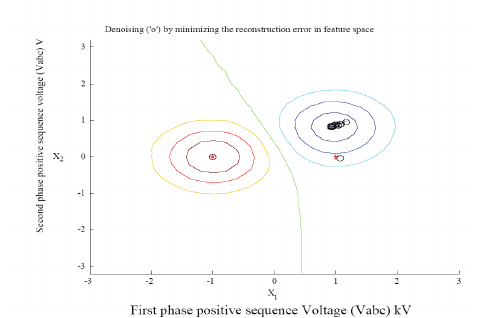
Fig. 5(e)(i). Fault location training performance of Hybrid Fig. 5(a). Decision boundary plot of RBF based SVM with approach for double line to ground fault (100-150Km) reconstructed input for double circuit of double line to ground fault from class -1 (This is the actual decision boundary). The contour plotted in blue are the points at distance +1 from the decision boundary, the orange contour are the points at distance -1. All examples plotted in red are